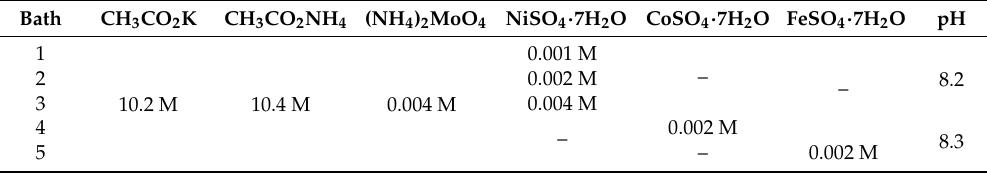
Table 1. Composition of electrolytes for Ni–Mo (Baths No. 1–3), Co–Mo (Bath No. 4) and Fe–Mo (Bath No. 5) coatings